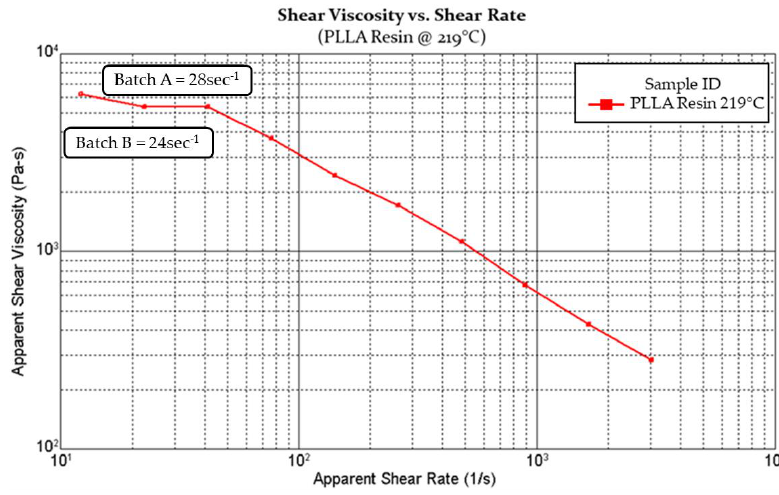
Figure 4. Capillary rheology curve of apparent shear viscosity vs. apparent shear rate.